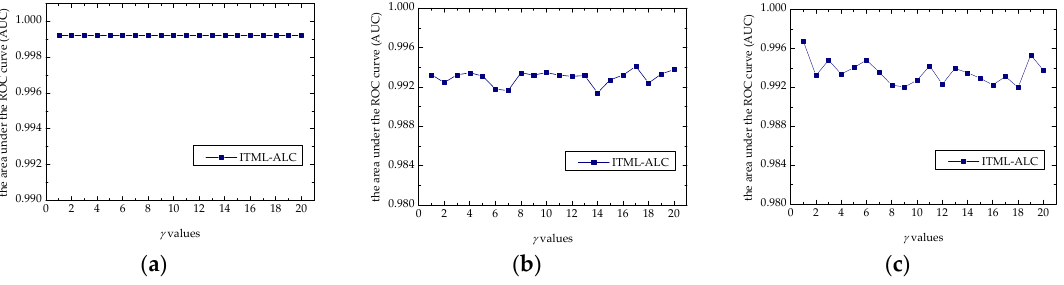
Figure 5. The AUCs of the proposed ITML-ALC method with respect to parameter γ . ( a ) AVIRIS LCVF dataset; ( b ) AVIRIS San Diego airport dataset; ( c ) HYDICE urban dataset.